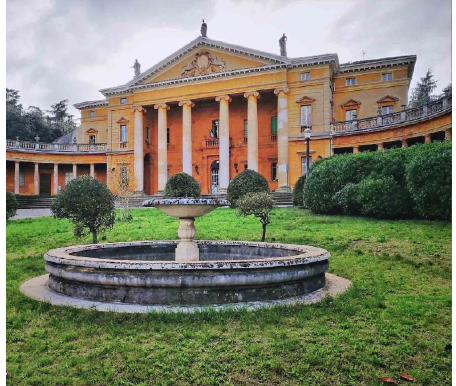
Figure 2. View of the Villa Aldrovandi Mazzacorati, which hosts the 1763 theatre [5].